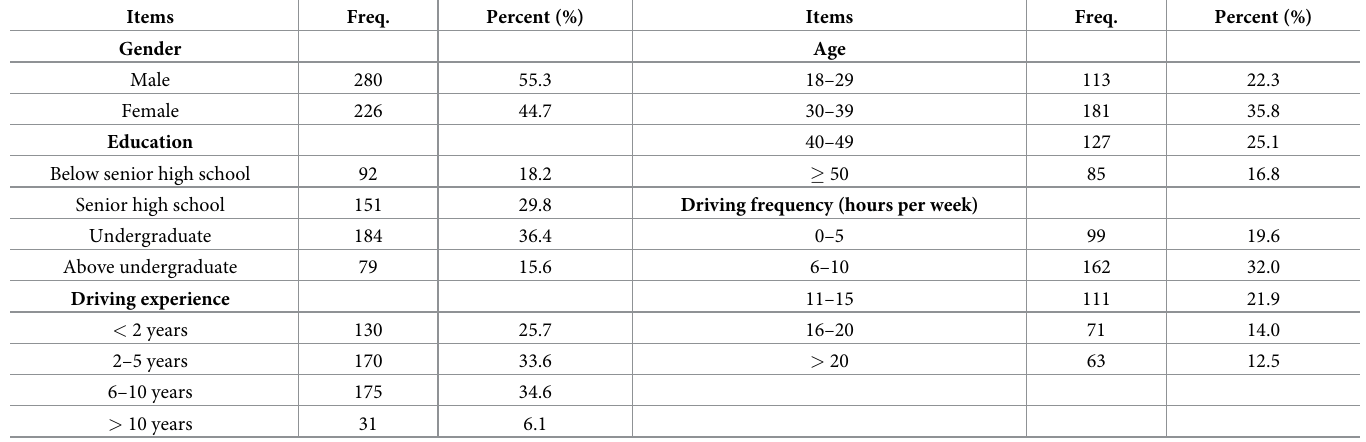
Table 2. Summary of respondents’ demographic information ( N =